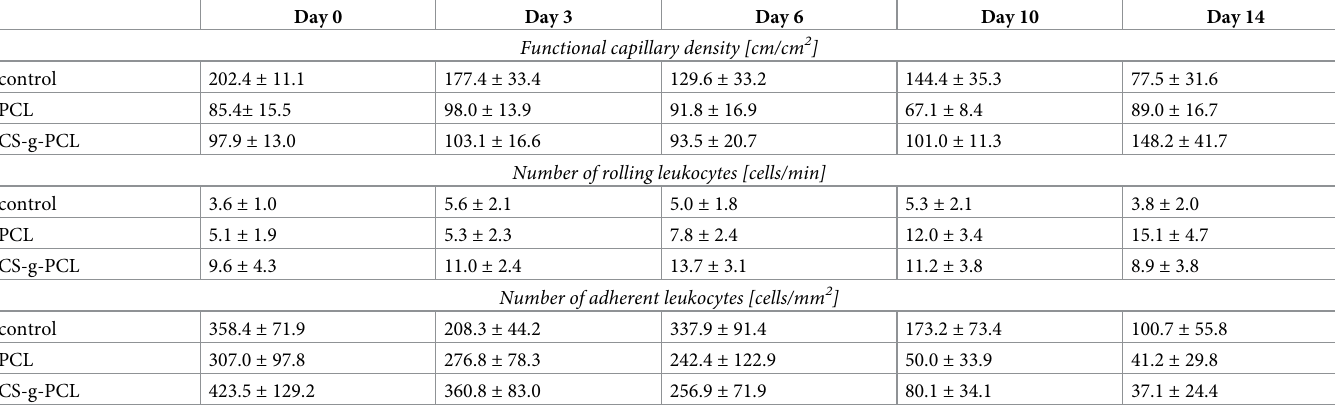
Table 3. Functional capillary density in cm/cm 2 , number of rolling leukocytes in cells/min and number of adherent leukocytes in cells/mm 2 at the periphery of the control group scaffold (control), the unmodified PCL fiber mat group (PCL) and PCL fiber mat modified with CS-g-PCL group immediately (d0) and 3, 6, 10 and 14 days after implantation. Values are expressed as means ±